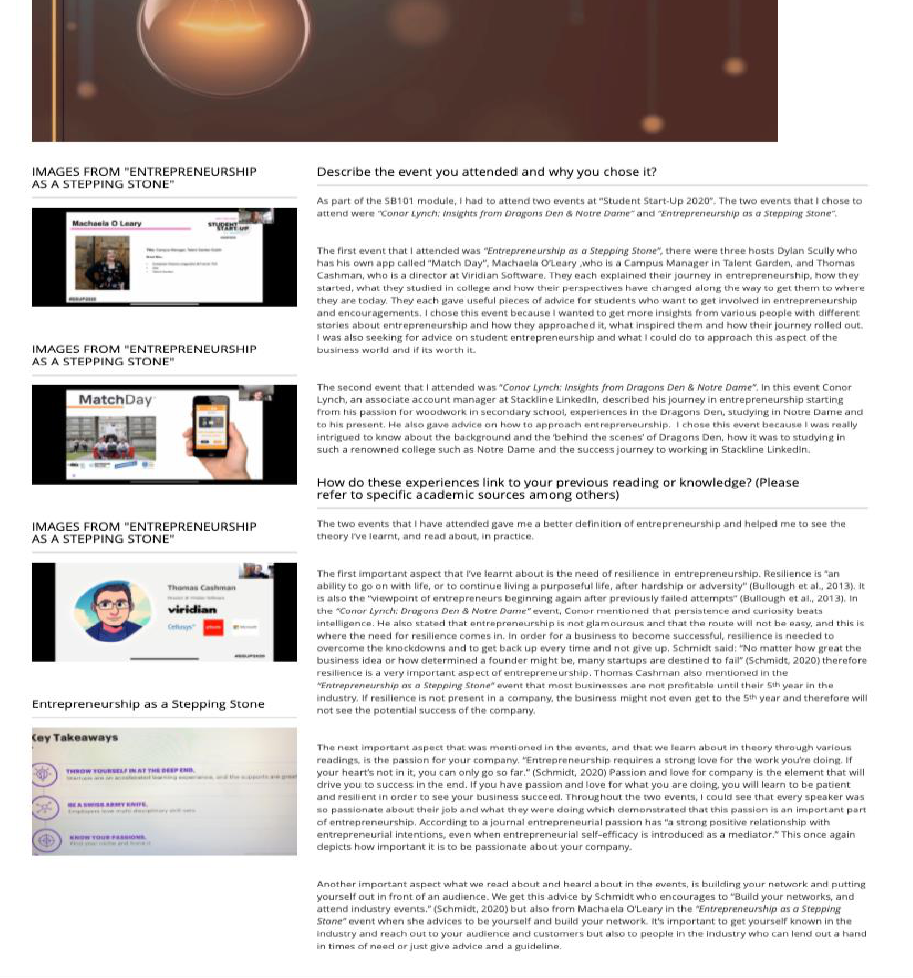
Figure 1: Student Portfolio